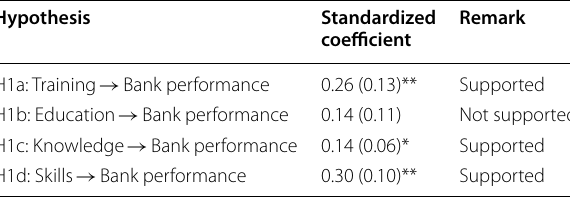
Table 5 Summary of hypothesis